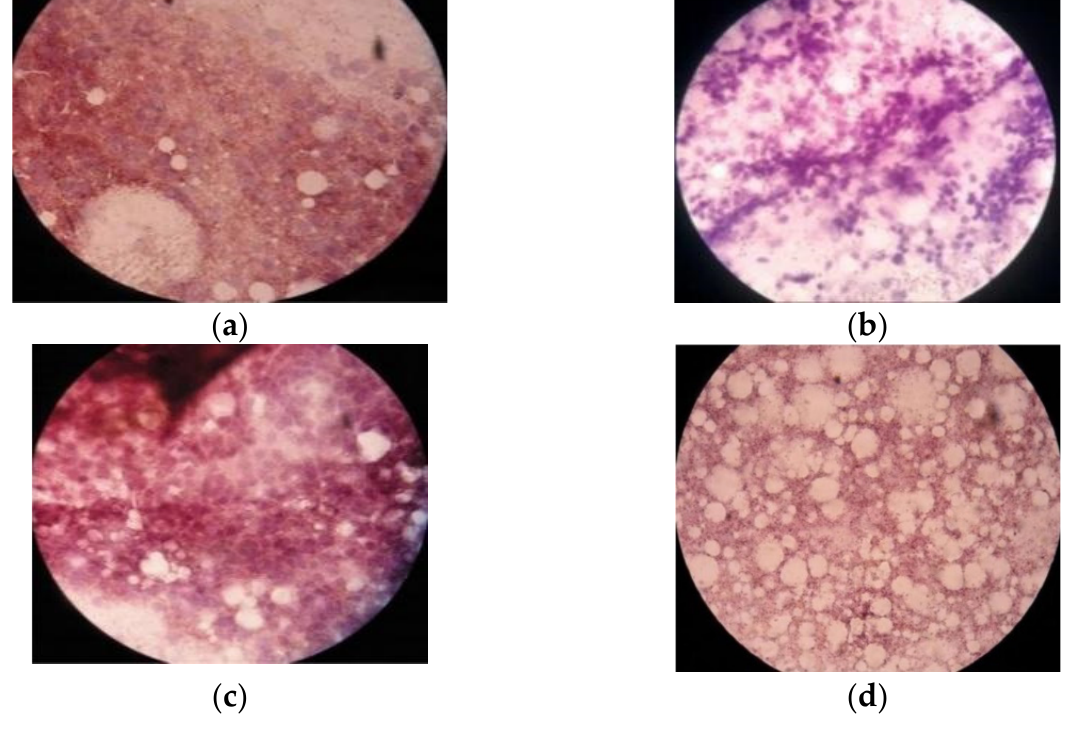
Figure 1. The results of microscopic preparations of the ISBPC assay: ( a ) positive control; ( b ) negative control; ( c ) positive result of Ae. Aegypti ; ( d ) negative result of Ae. Albopictus . The presence of antigen was indicated by the brown color of the granules and cytoplasm of hemocytes from head squash preparations. A negative result is indicated by the absence of visible brown or blue color.